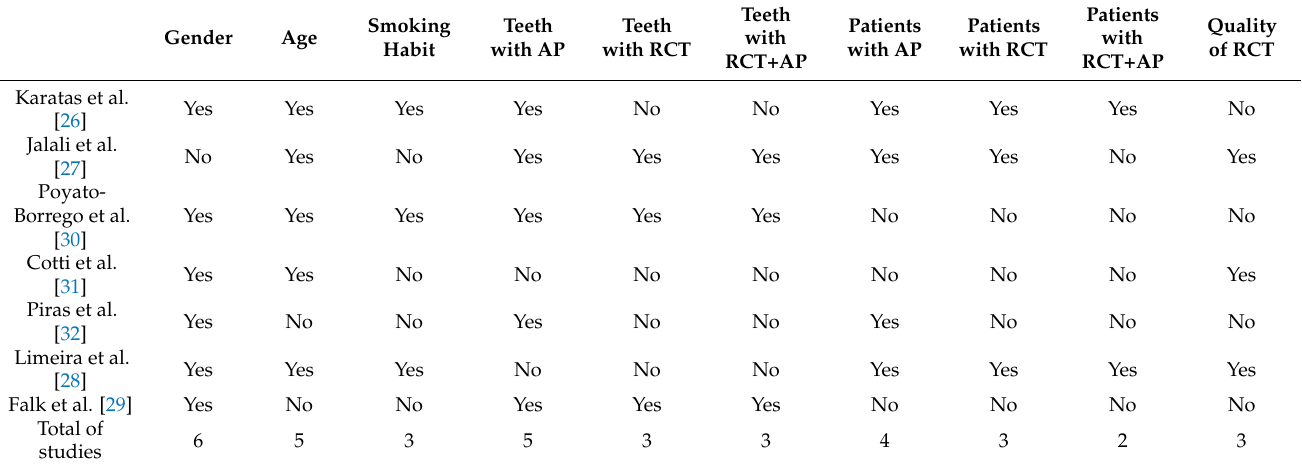
Table 5. Analyzed variables of included